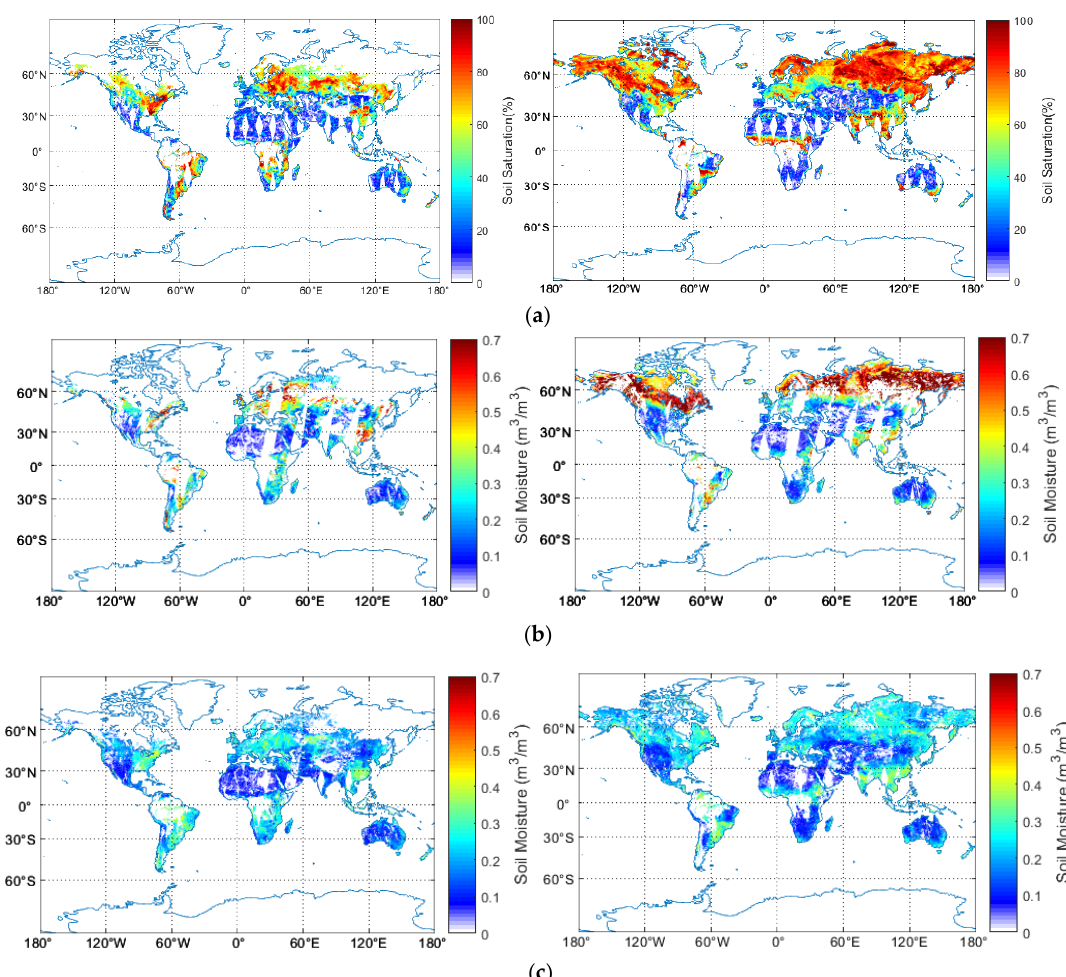
Figure 3. Spatial distribution of European Space Agency Climate Change Initiative (ESA CCI) soil moisture retrieved from ( a ) active ( b ) passive ( c ) combined microwave signals on 15 April (left) and 27 July (right) 2014.